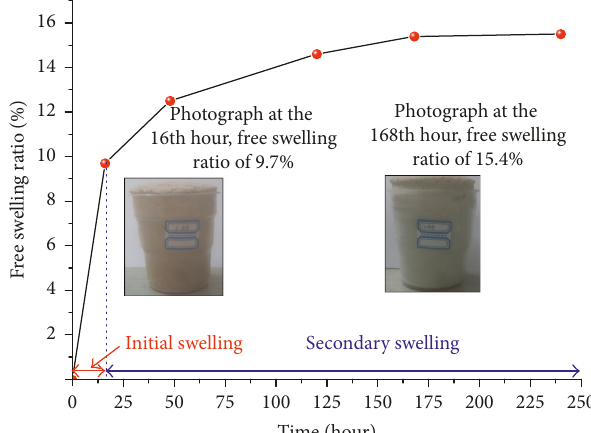
Figure 1: Free swelling ratio of the DE material during hydration with macrographs of the material at the 16th hour and the 168th